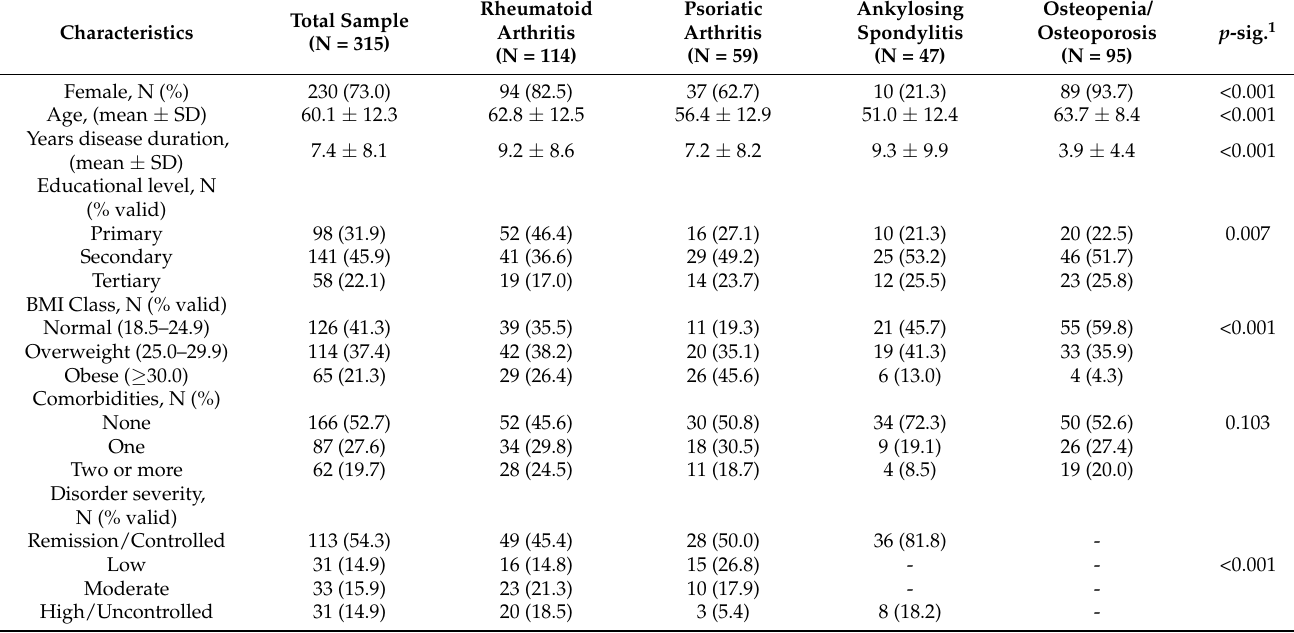
Table 1. Demographic and clinical characteristics of the sample.